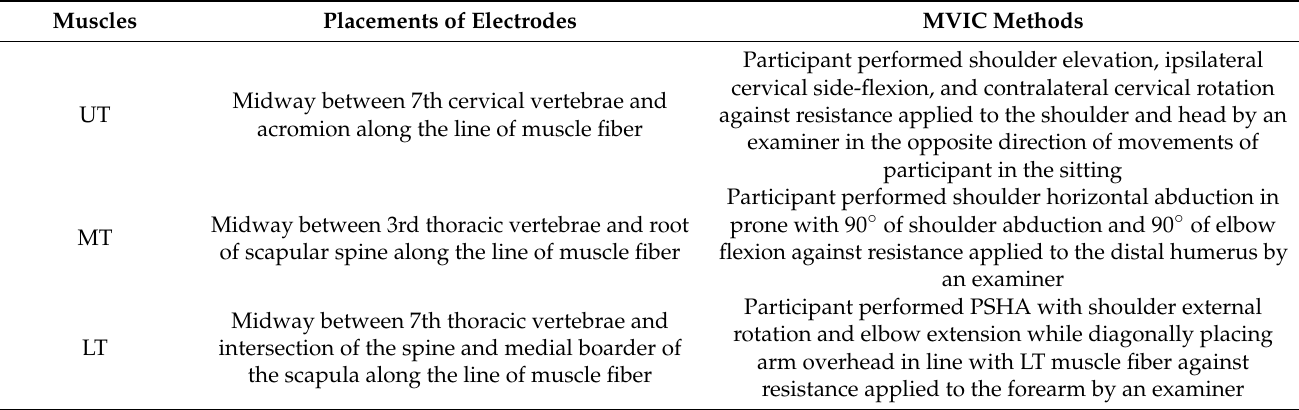
Figure 1. Placements of electrodes for trapezius muscles. Table 1. Placements of electrodes and maximal voluntary isometric contraction methods for each